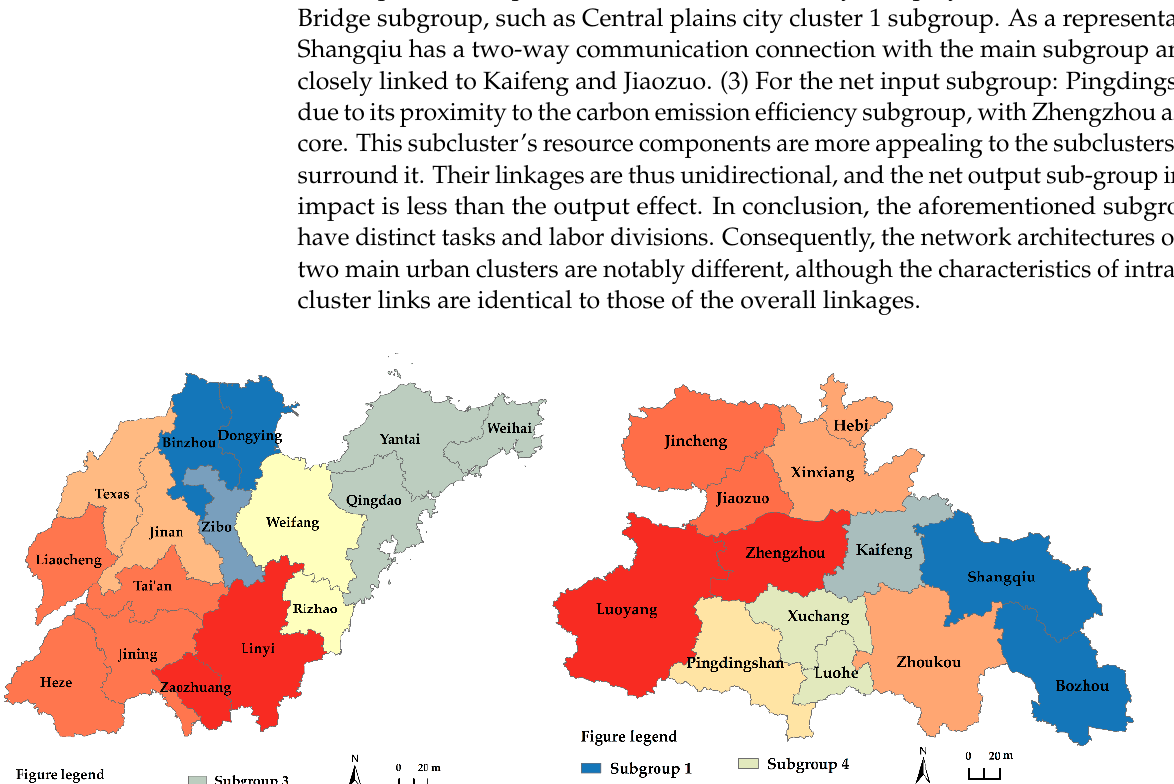
Figure 8. Division of two major urban agglomerations into cohesive